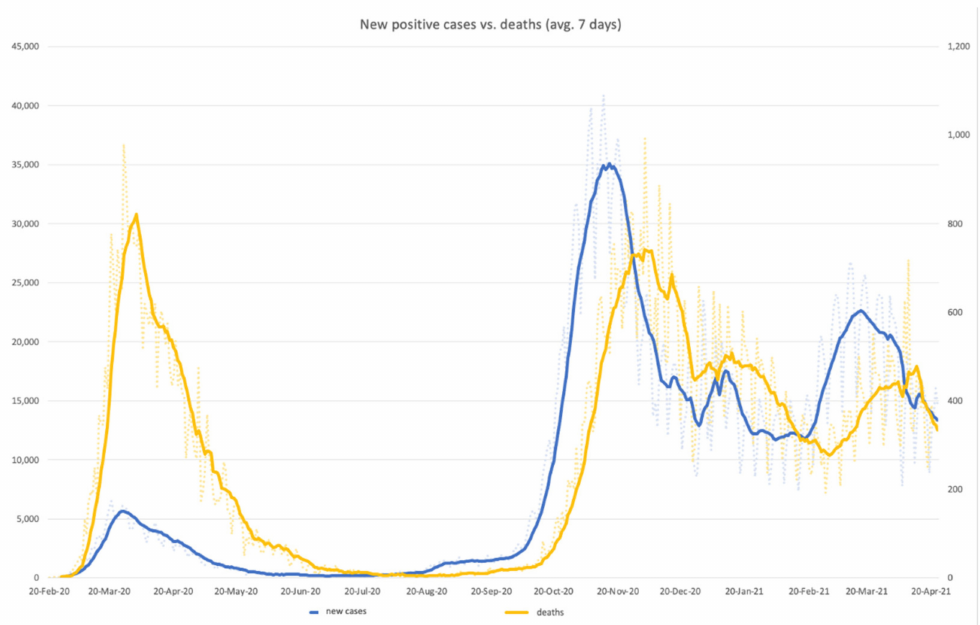
Figure 1. Observed real curves for new daily cases and deaths in